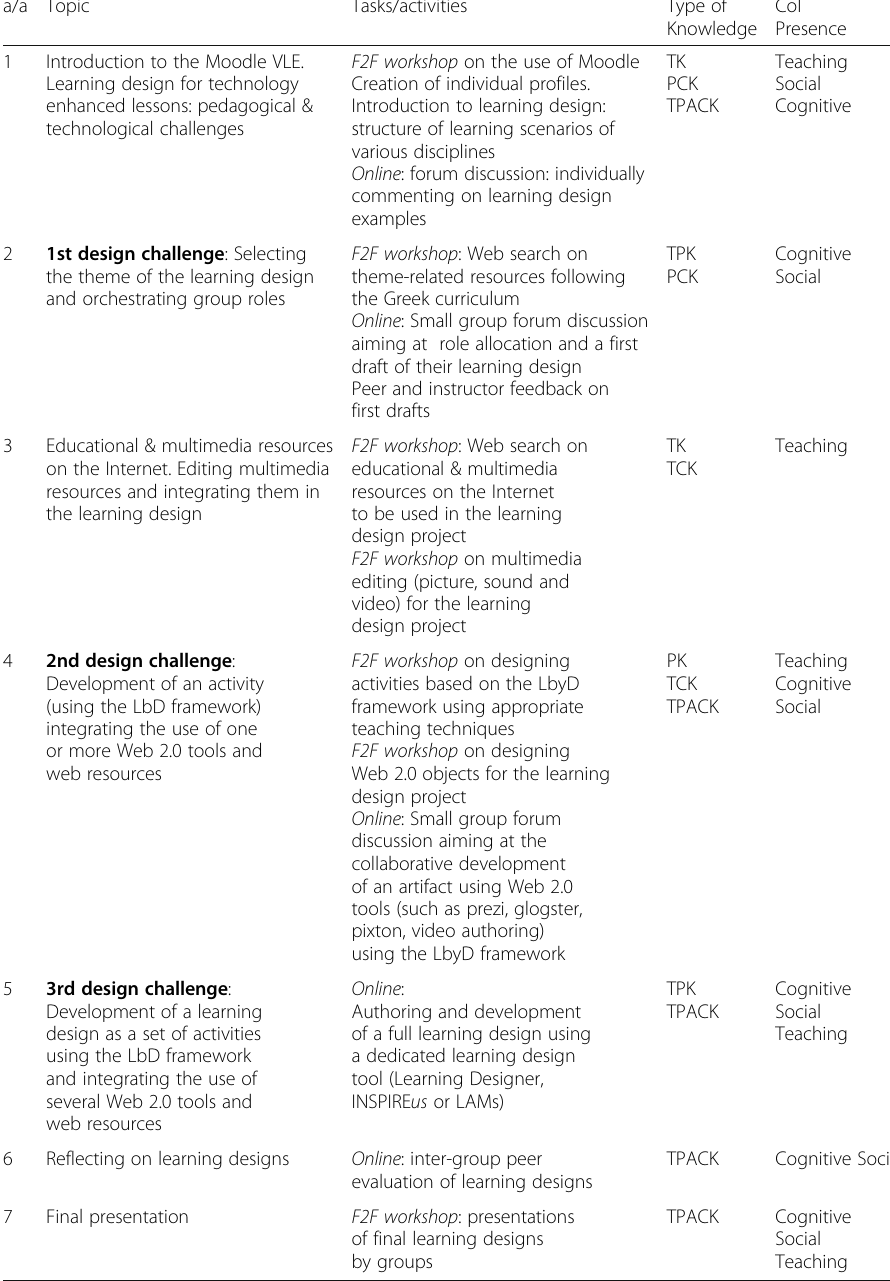
Table 2 Curriculum organized around design challenges cultivating synthetic types of knowledge and prioritizing specific types of online